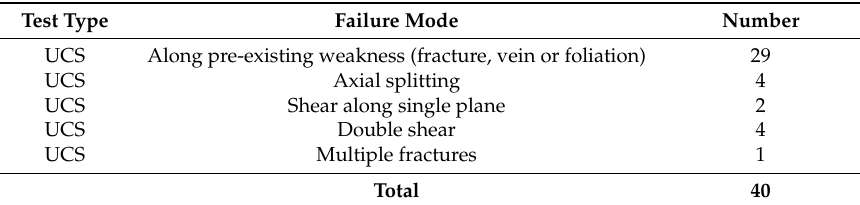
Table 3. Table with samples grouped based on their failure mode during the UCS tests.